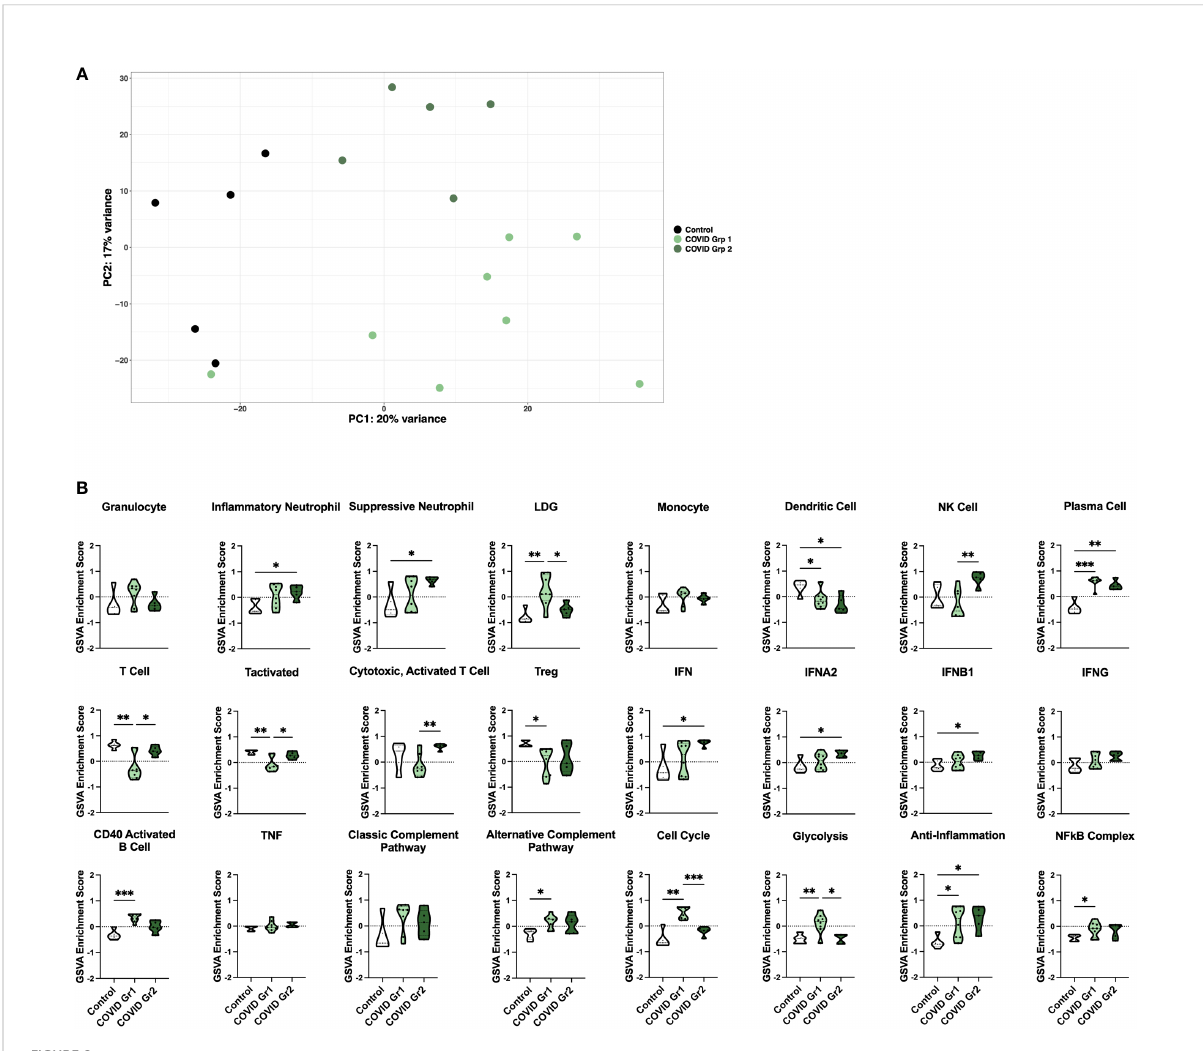
FIGURE 2 Enrichment of in fl ammatory cell types and pathway gene signatures in gene expression-derived COVID-19 AHRF patient groups. (A) Principle component analysis of the top 500 variable genes between control (black) and COVID-19 (green) ICU patients. COVID-19 patients were further separated into COVID Group 1 (light green) and COVID Group 2 (dark green). (B) Individual sample gene expression from (A) was analyzed by GSVA for enrichment of immune cell and pathway gene signatures. Enrichment scores are shown as violin plots. *p < 0.05, **p < 0.01, ***p <